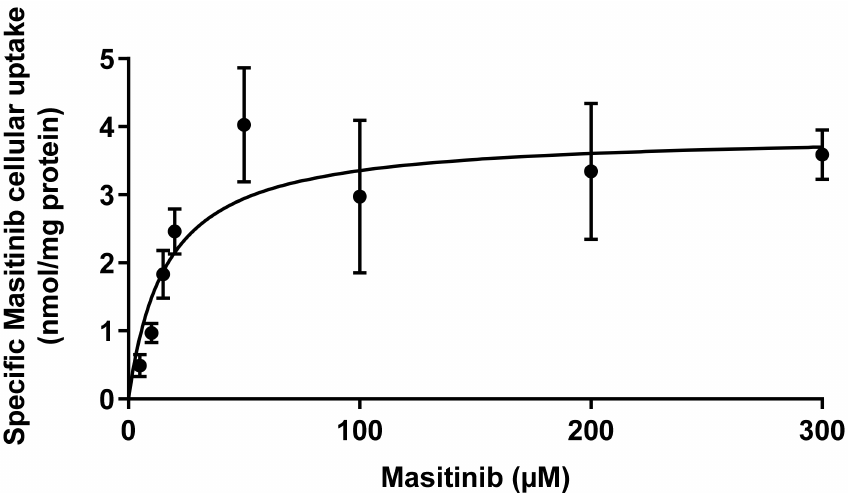
Figure 5. Saturation kinetic of Masitinib in hOCT1-HEK293 cells. Three independent experiments were performed. The values are shown as mean ± SEM. Fitting of the curve according to a Michaelis– Menten kinetic gave the following values for K m and V max :K m = 16.3 ± 5.2 µ M Masitinib and V max = 3.9 ± 0.3 nmol Masitinib/mg protein ( n =